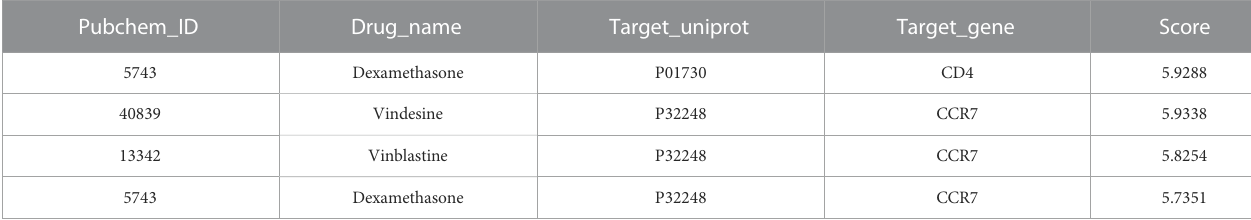
TABLE 2 ( Continued ) Predicted drugs with interactions with 17 key targets.